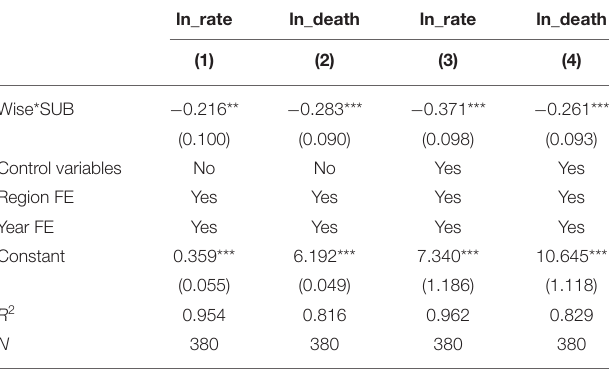
TABLE 9 | Results of different administrative